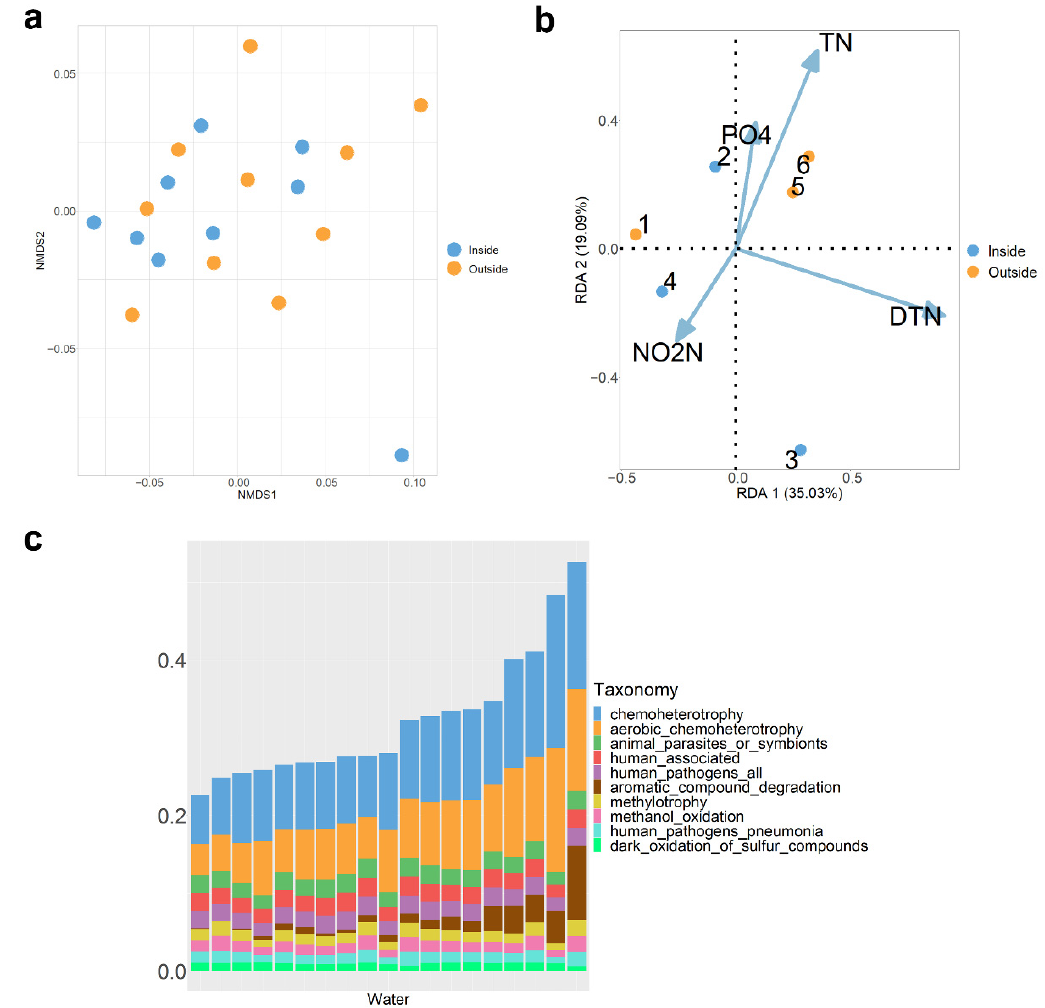
Figure 4. Characteristics of water microbiota. ( a ) NMDS ordination of microbiota in inside and outside water based on the weight Unifrac distance; ( b ) RDA of water microbiota and environmental factors (TN represents total nitrogen, DTN represents total dissolved nitrogen, NO2N represents nitrite nitrogen, and PO4 represents phosphate); ( c ) Top 10 predicting functions of water microbiota; the vertical axis represents the average proportion of each